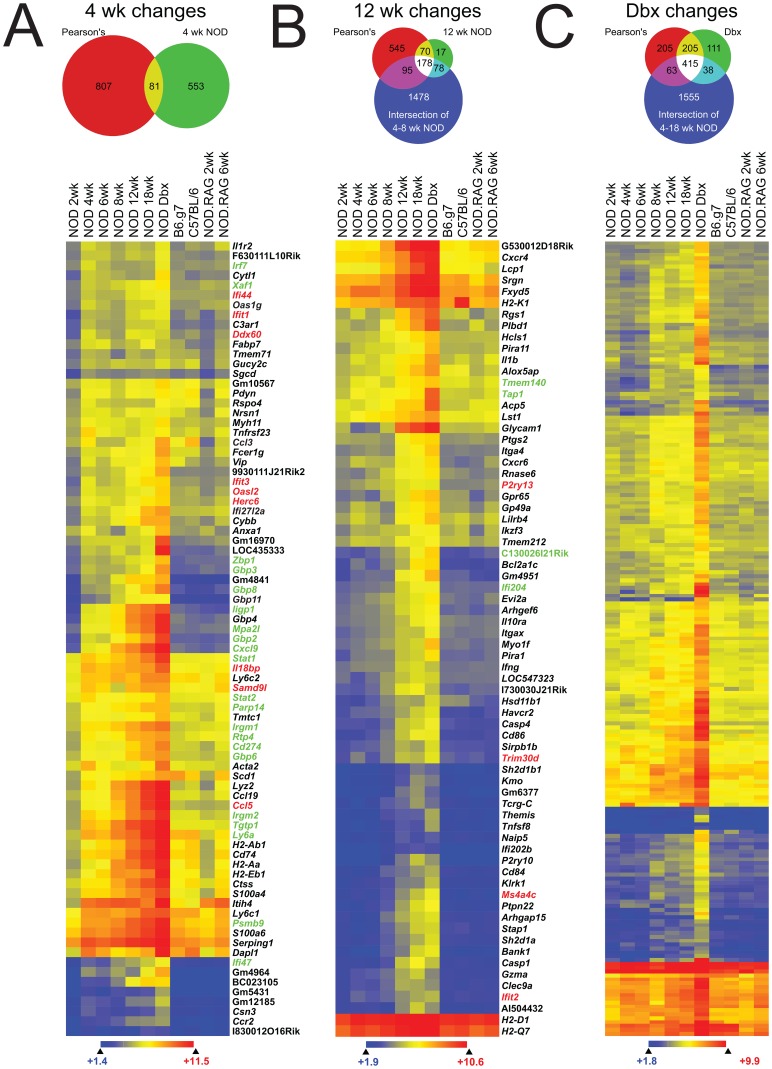
Identification of significant gene changes in different aged NOD mice.Examination of transcriptional changes that took place between 2 wks and either (A) 4 wks, (B) 12 wks, or (C) newly diabetic NOD mice. The red portion of each Venn diagram shows the genes identified by Pearson’s correlation as following a positive correlation throughout diabetogenesis. The green portion of each Venn diagram shows statistically significant changes from 2 wks to the given wk as determined by 2-fold upregulation and 99% confidence interval by moderated t test with Benjamini-Hochberg false discovery rate analysis. The blue portion of the Venn diagrams is the intersection of all the pairwise statistically significant differences from 2 wks to the indicated ages. Hierarchically clustered heat maps show the Euclidean distance of genes identified by the yellow intersection in the Venn diagrams. Those were the genes that showed both a positive correlation by Pearson’s correlation and a pairwise fold and statistical change at the indicated time. Gene names in red are type I interferon-inducible and those in green are inducible by both type I and type II interferons.